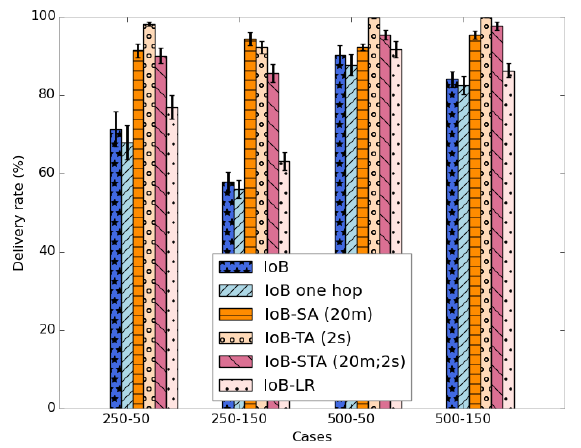
Figure 39. Average delivery rate